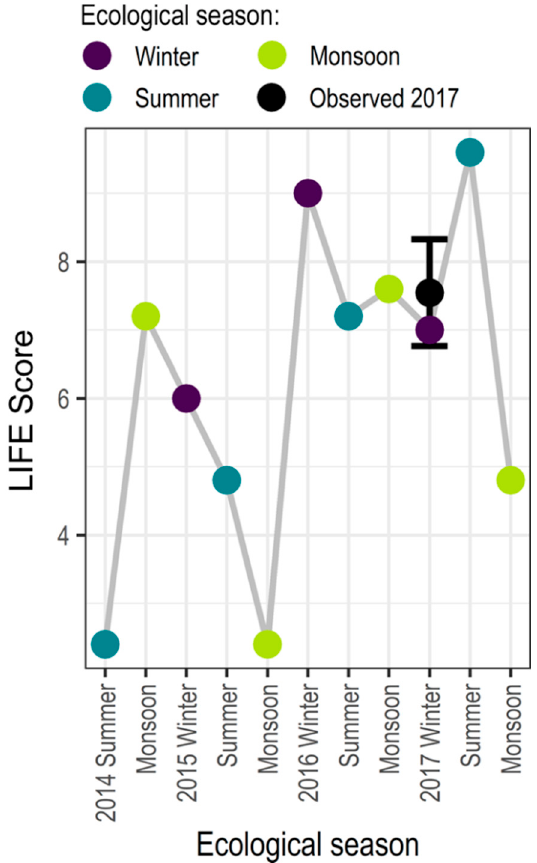
Figure 7 . Validation of the hydroecological model. Simulated seasonal LIFE scores from 2014–2017 (hydrological years). The observed data, two samples collected in winter 2017, are indicated in black, with the circle representing the mean LIFE score.